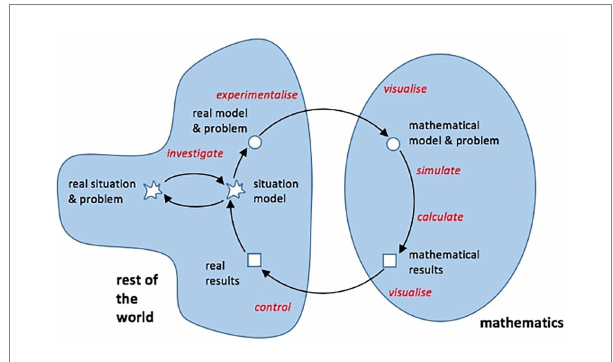
FIGURE 2 Usage of digital technology in mathematical modelling (Blum and Leiß, 2007, p. 22; Greefrath, 2011, p.